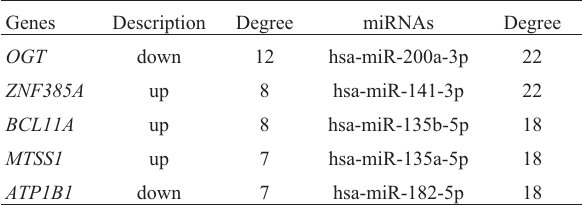
Table 1 - The top 5 DEGs and miRNAs in miRNA-DEG regulatory net- work. Genes